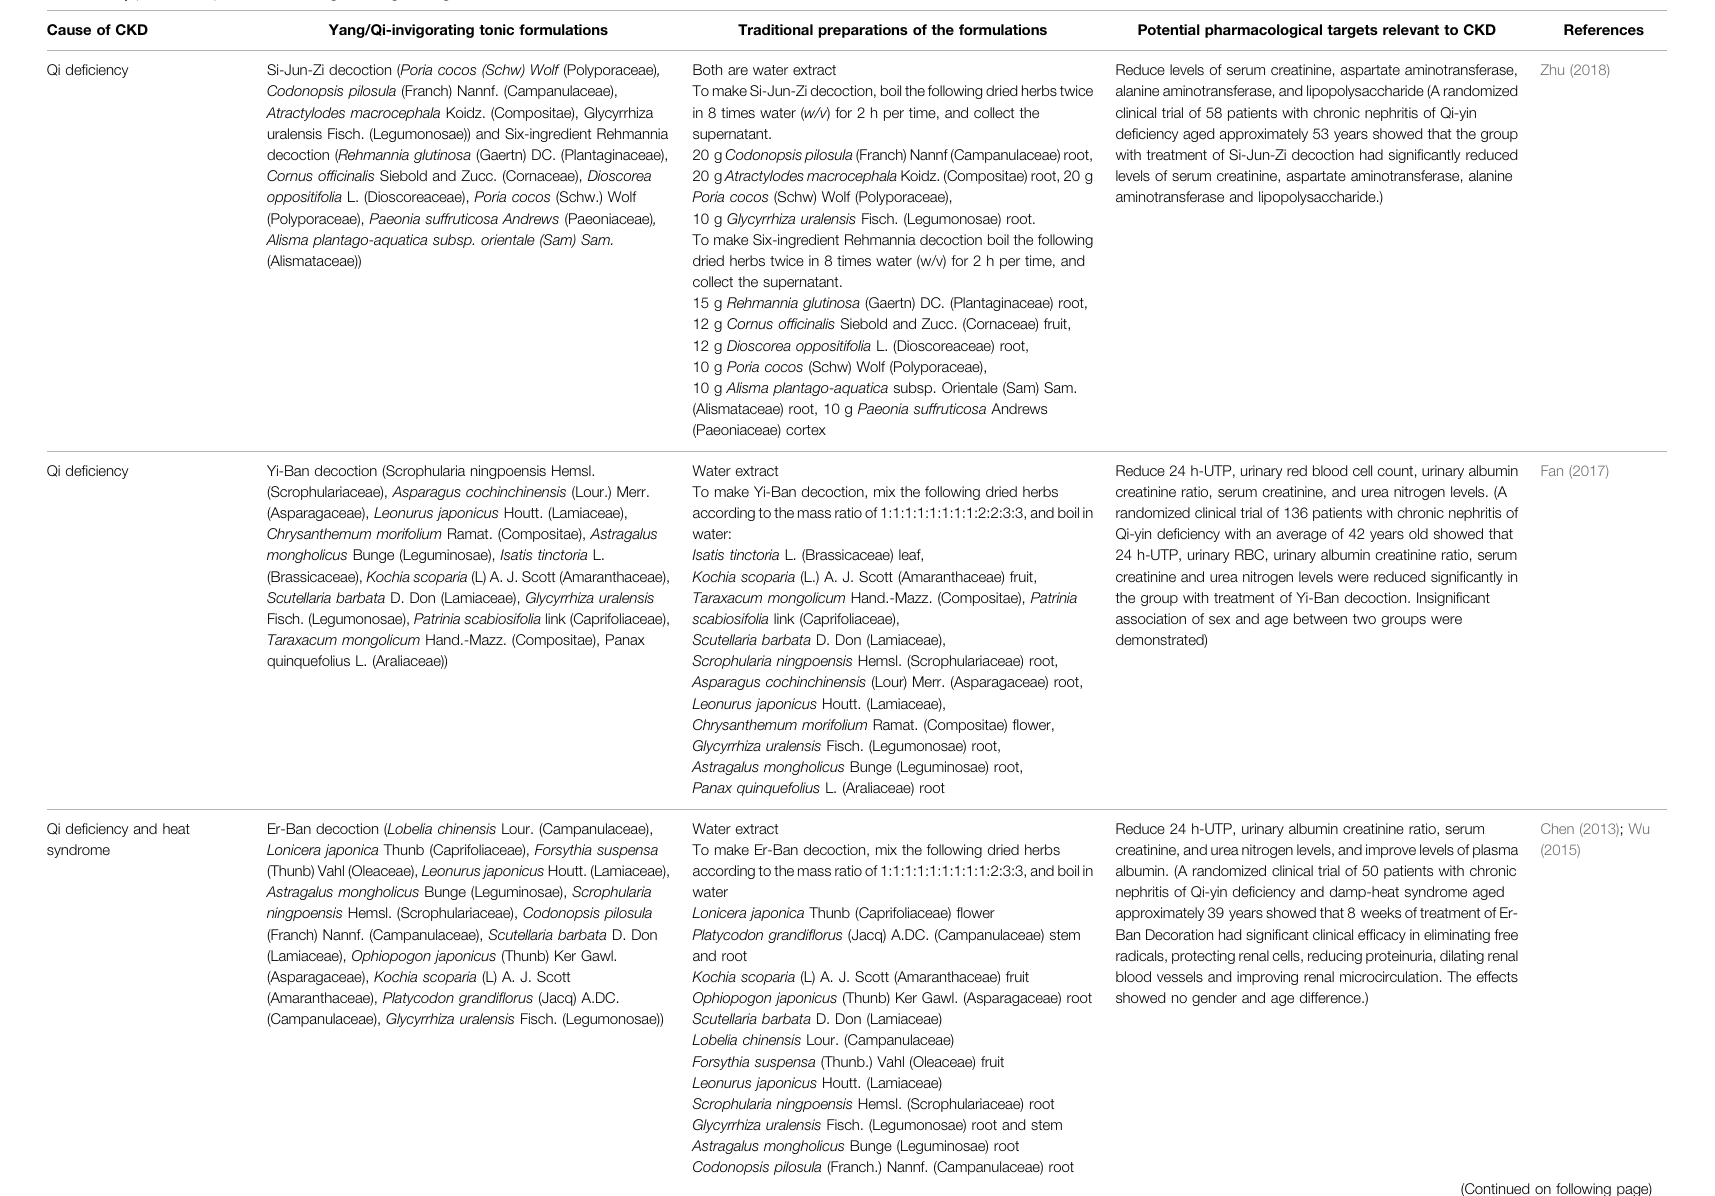
TABLE 1 | ( Continued ) Effects of Yang/Qi-invigorating formulations on the treatment of